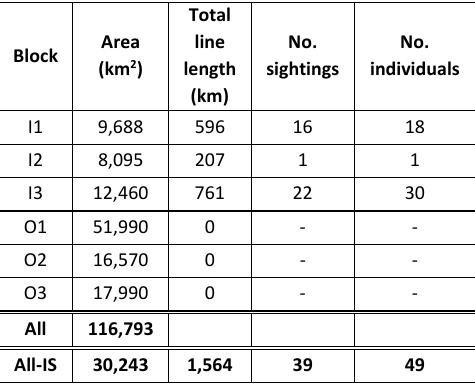
Table 4. Animal abundance (N) and density (D; Indiv/km 2 ) estimates by survey block and for the total area covered during the 2010 Faroese aerial survey. "Total (excl. I2)” excludes block I2 due to low coverage and only a single sighting. Estimates of esw (incorporating g (0) ) taken from